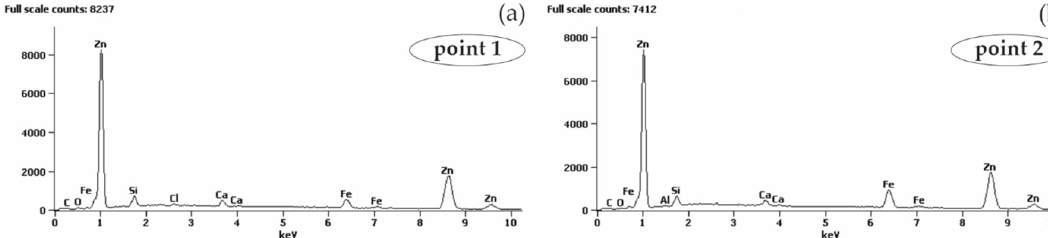
Figure 15. Microstructure of the joint between concrete without chlorides and reinforcing steel B500SP with zinc coating (SEM): ( a ) general view of a cross-section of a steel bar in concrete ( b ) morphology of the boundary of separation rebar - concrete with marked places 1 and 2 for microanalysis of the chemical composition.